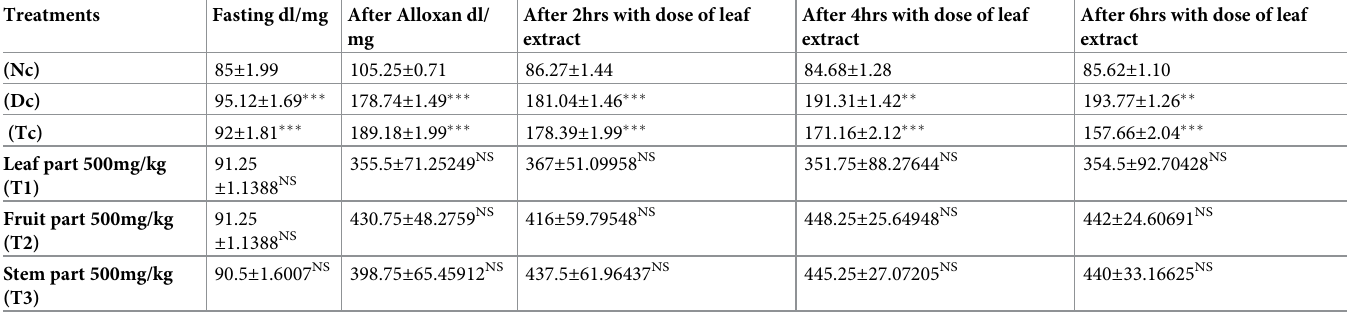
Table 2. Effects of E . spinosa leaf, stem, and fruit methanolic extract on blood glucose levels in alloxan-induced diabetic rats after a single oral dose ( blood glucose level measured in mg/dl